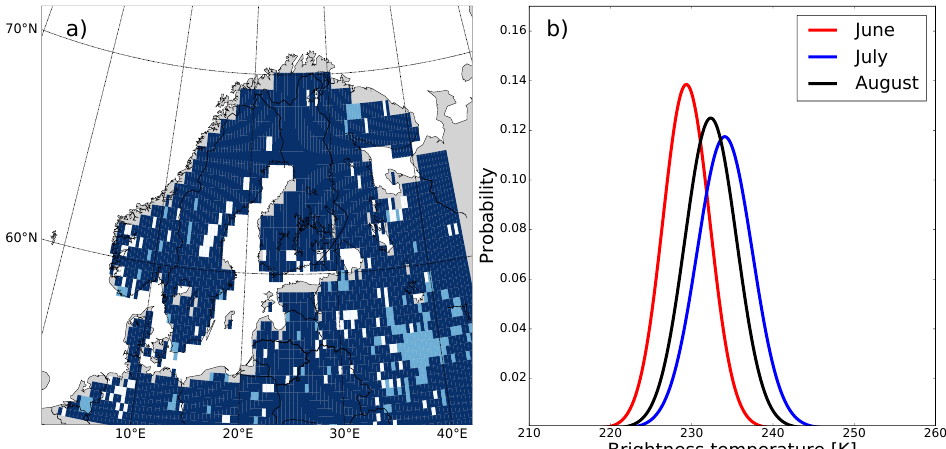
Figure 1. ( a ) Shapiro-Wilk test for normality of the Tb H distribution shown for July. Dark blue regions null-hypothesis is not rejected, i.e., the data appears to be normally distributed. Light blue regions null-hypothesis is rejected, and white regions (over land) had too few years of data for testing. ( b ) Example PDFs of the fitted brightness temperature for boreal summmer months, June (red), July (blue) and August (black) for the grid-cell covering 63.7 ◦ N and 12.0 ◦ E. The Gaussian fit to the Tb H for June (red), July (blue) and August (black) are shown for